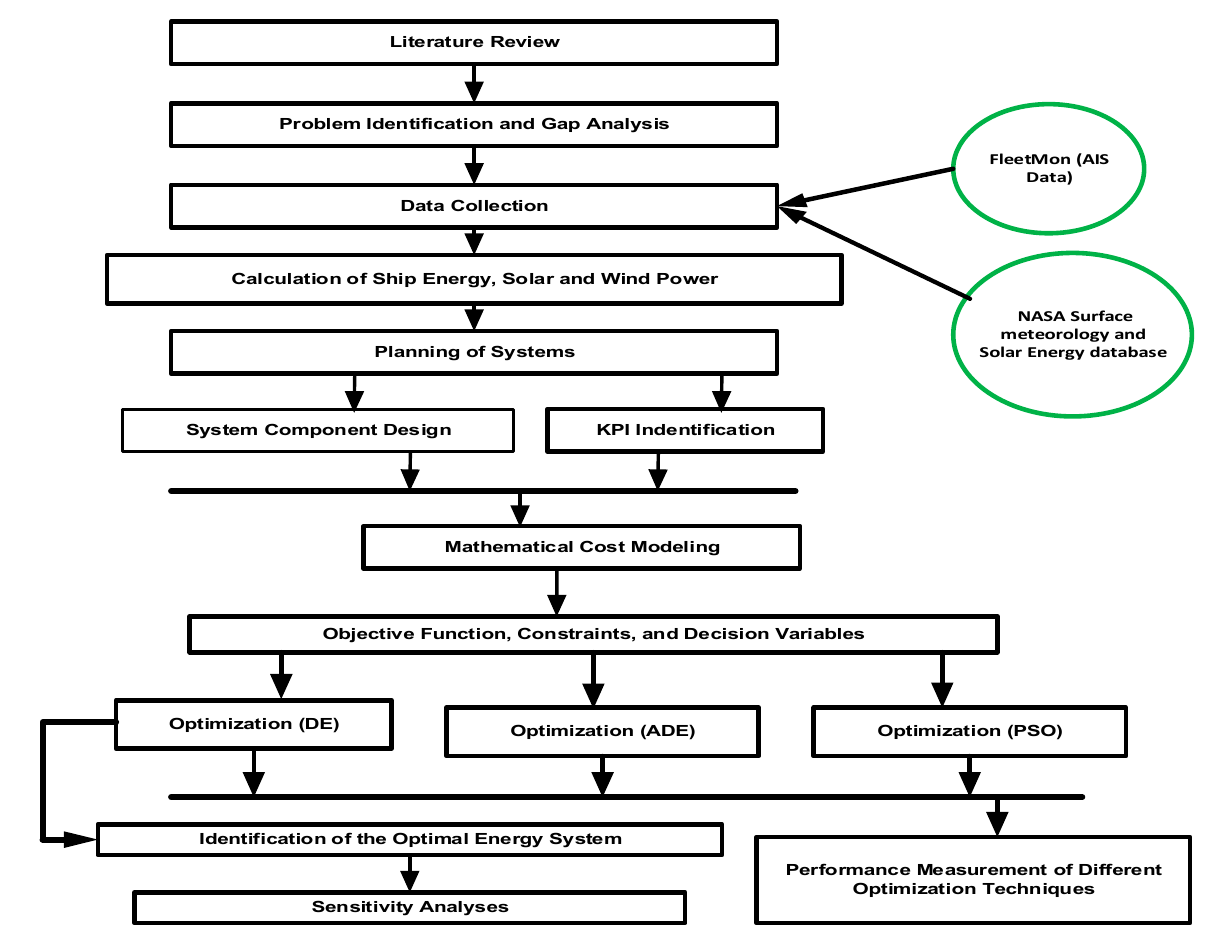
Figure 1. Framework of the Study.